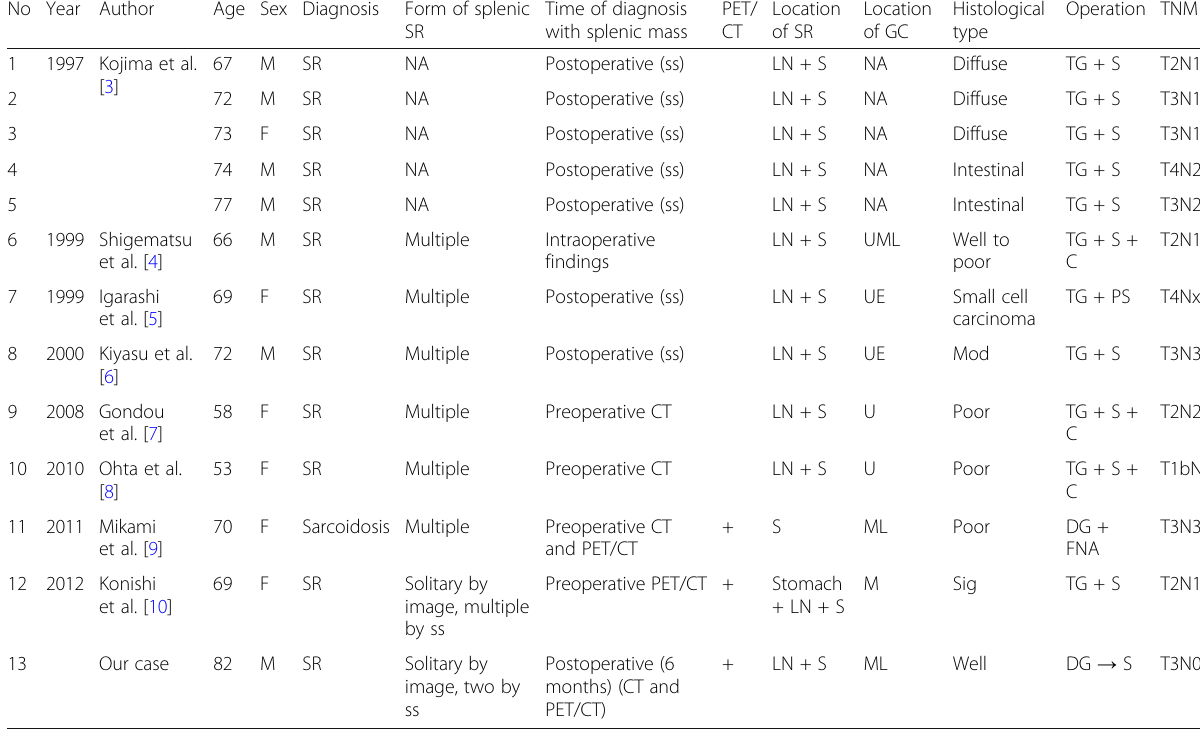
Table 1 Summary of patients with gastric cancer and splenic sarcoid